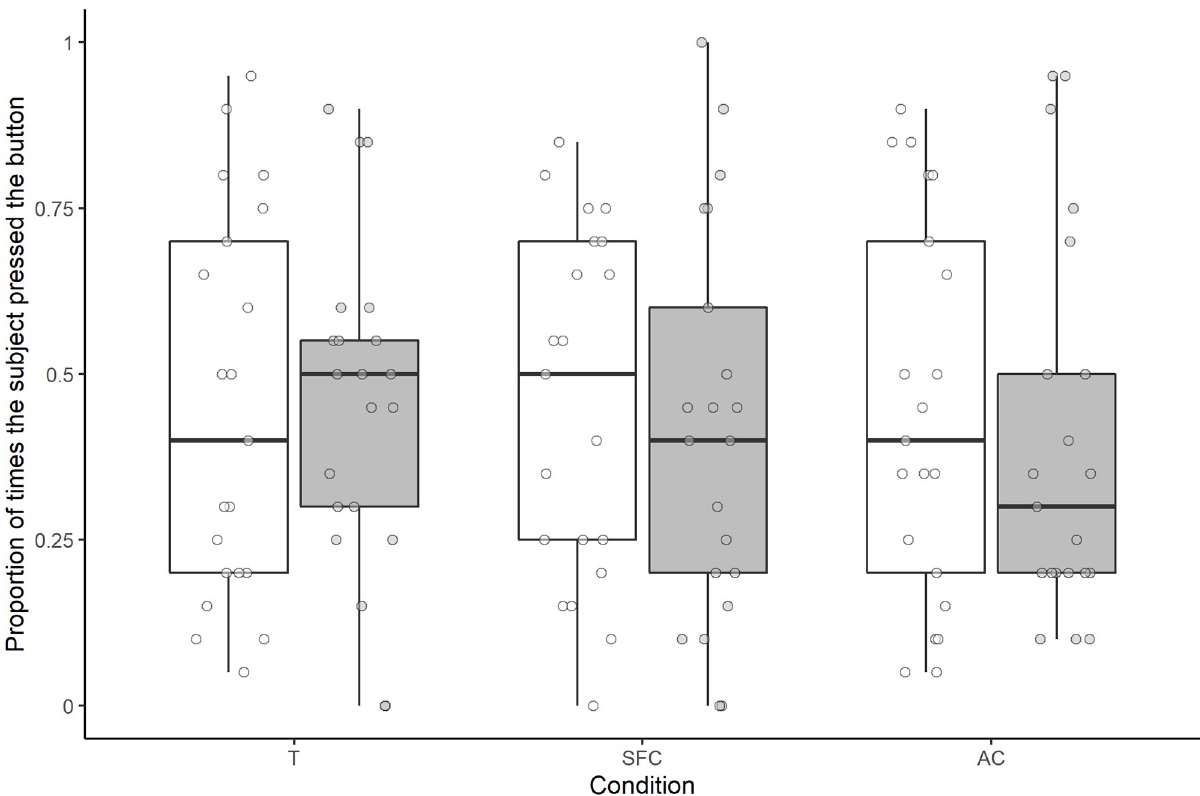
Fig 6. Proportion of times the subjects pressed the button in each condition for each human type. Pressing for the helpful human is represented in white and pressing for the unhelpful human is represented in grey. Boxes display the interquartile range, black horizontal bars represent the median, whiskers represent the range of data points within 1.5 times the interquartile range from the upper and lower hinge, and circles represent individual data points. T, test; SFC, social facilitation control; AC, asocial control.